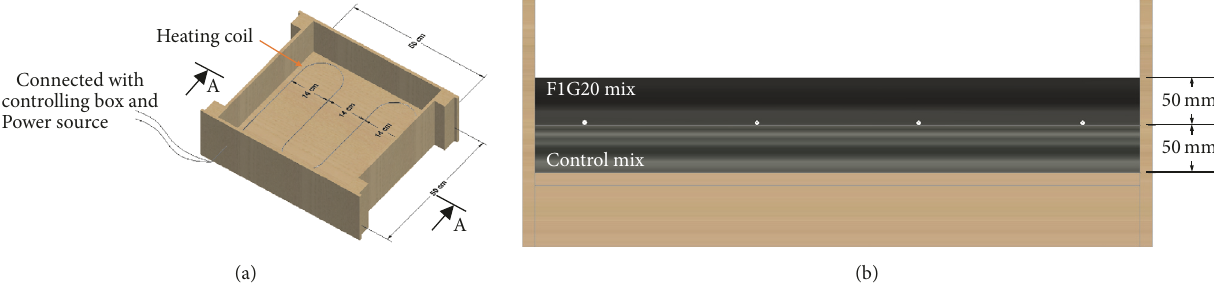
Figure 3: Sketch of (a) test box model and (b) cross-section A-A.